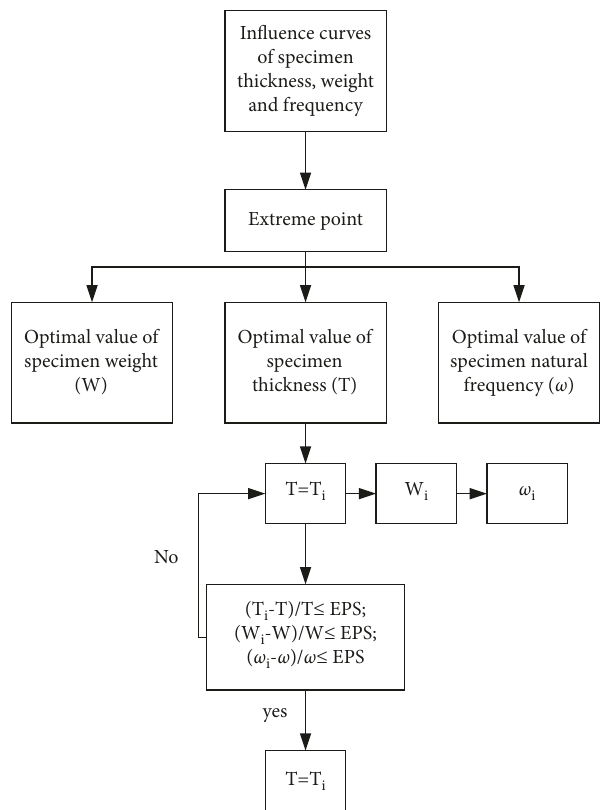
Figure 12: Technical route of structural